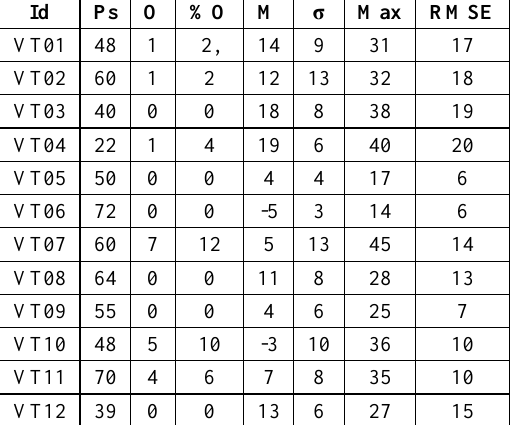
Table 5. Statistics of first campaign. Id, Number of RTK Points, Number of Outliers, Percentage of Outliers, Mean, Standard deviation, Absolute Maximum value, Root Mean Square Error. All metric results in cm.